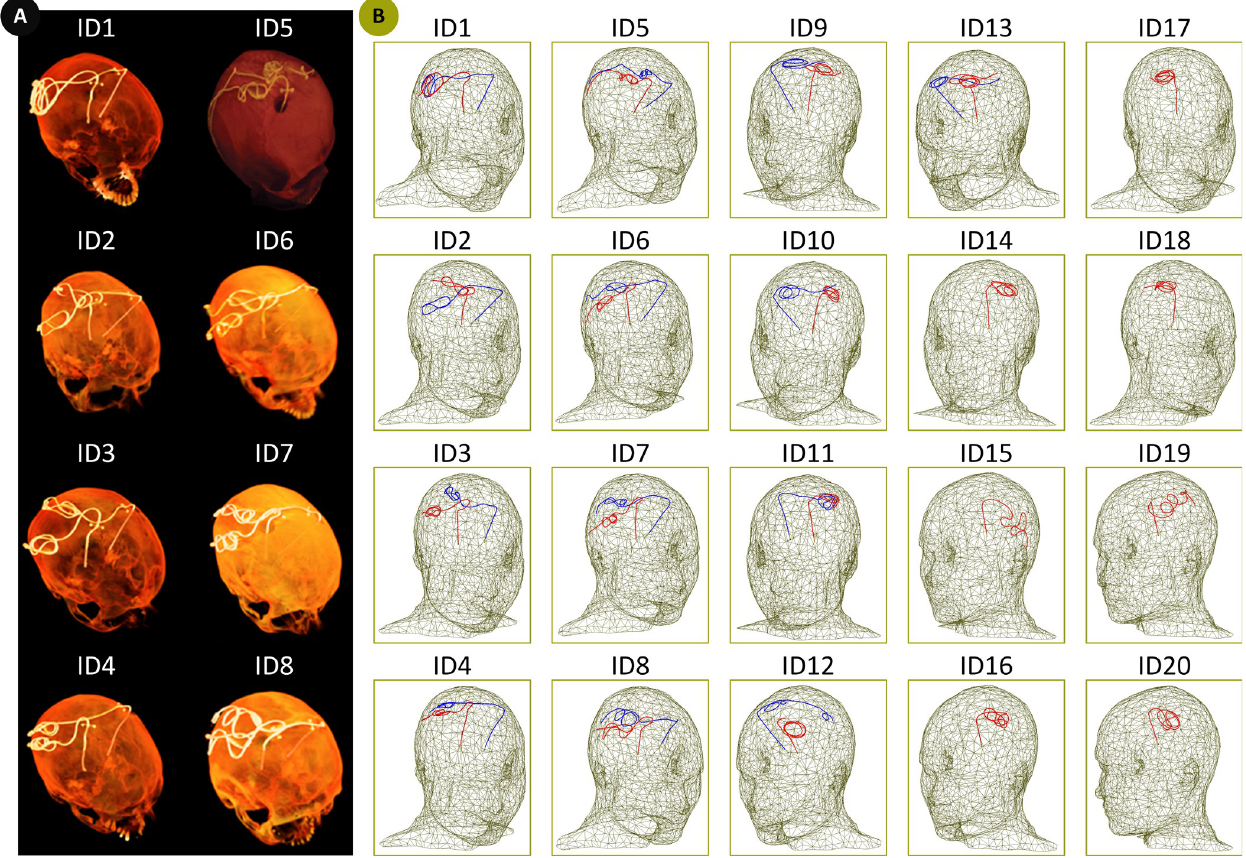
Fig 2. (A) Examples of postoperative CT images (ID1-ID8). (B) Reconstructed models of isolated DBS leads (ID1—ID20). Lead trajectories were constructed based on the postoperative CT images of 13 patients with bilateral DBS implantations (ID1—ID13), and 7 patients with unilateral DBS implantations (ID14—ID20) and were incorporated in a homogeneous head model for EM simulations.